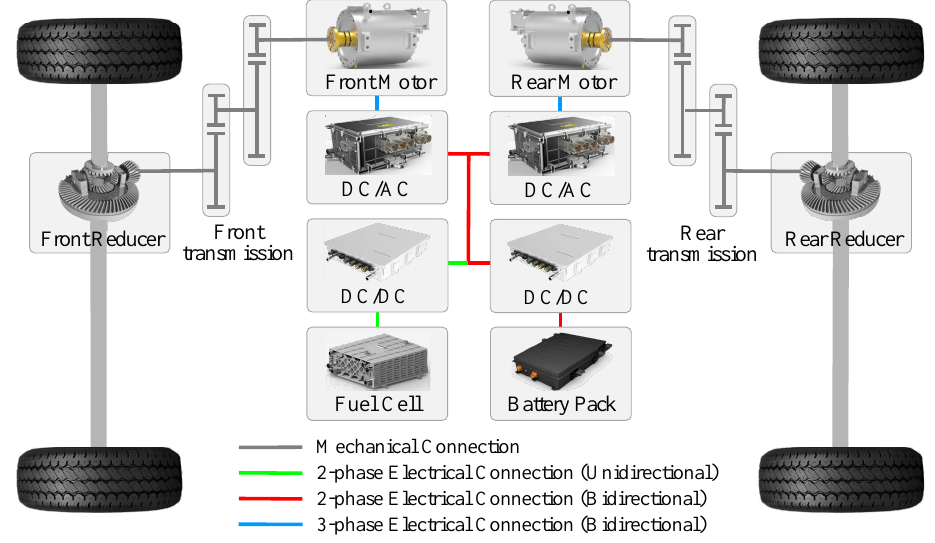
Figure 1. Powertrain configuration of the studied